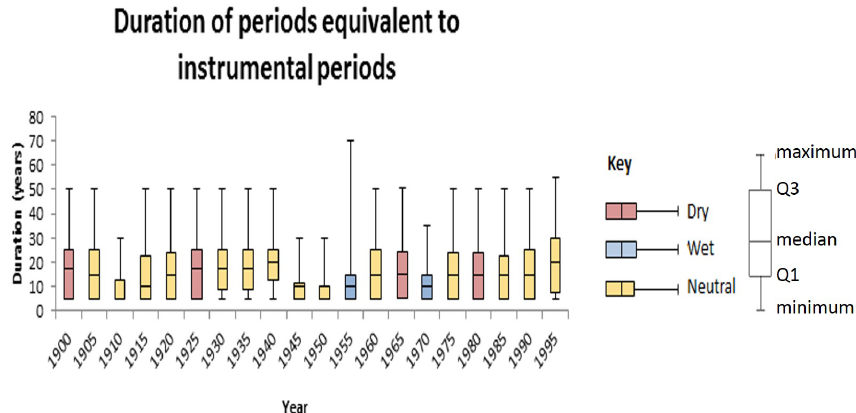
Figure 6. Duration of pre-instrumental periods with similar hydroclimatic conditions to the 5-year periods from the instrumental record. Instrumental periods identified as being wet, dry, or neutral are coloured